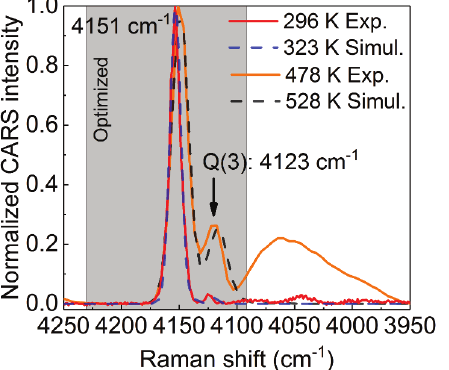
Fig. 3. Experimental and simulated fs-CARS spectrum for temperature determination based on H 2 at 296 K (simulated 323 K) and 478 K (simulated 528 K) of 1.4 bar. The shadowed grey area shows the optimization range for temperature